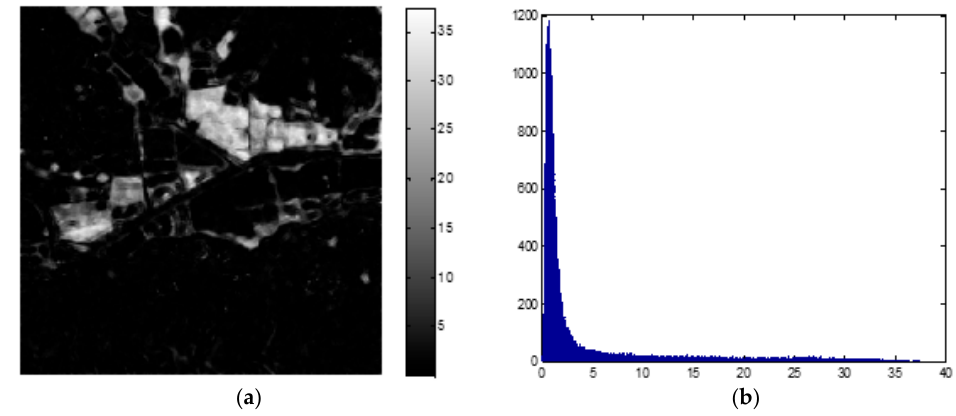
Figure 7. ( a ) The DI based on pixels; ( b ) Histogram of the DI based on pixels.